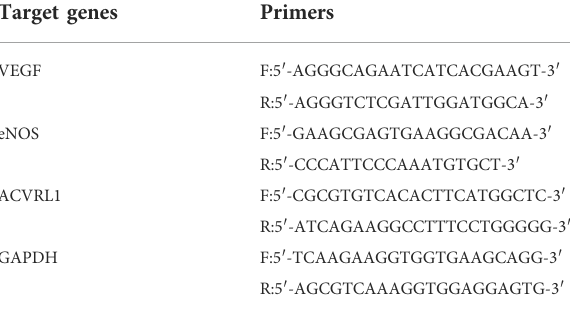
TABLE 2 Primer sequence for the HUVECs used in this